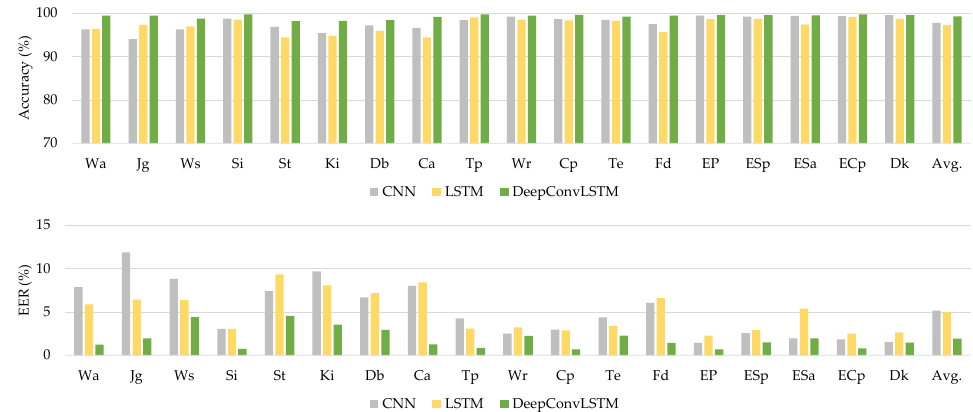
Figure 7. The comparative results using the WISDM-HARB dataset.